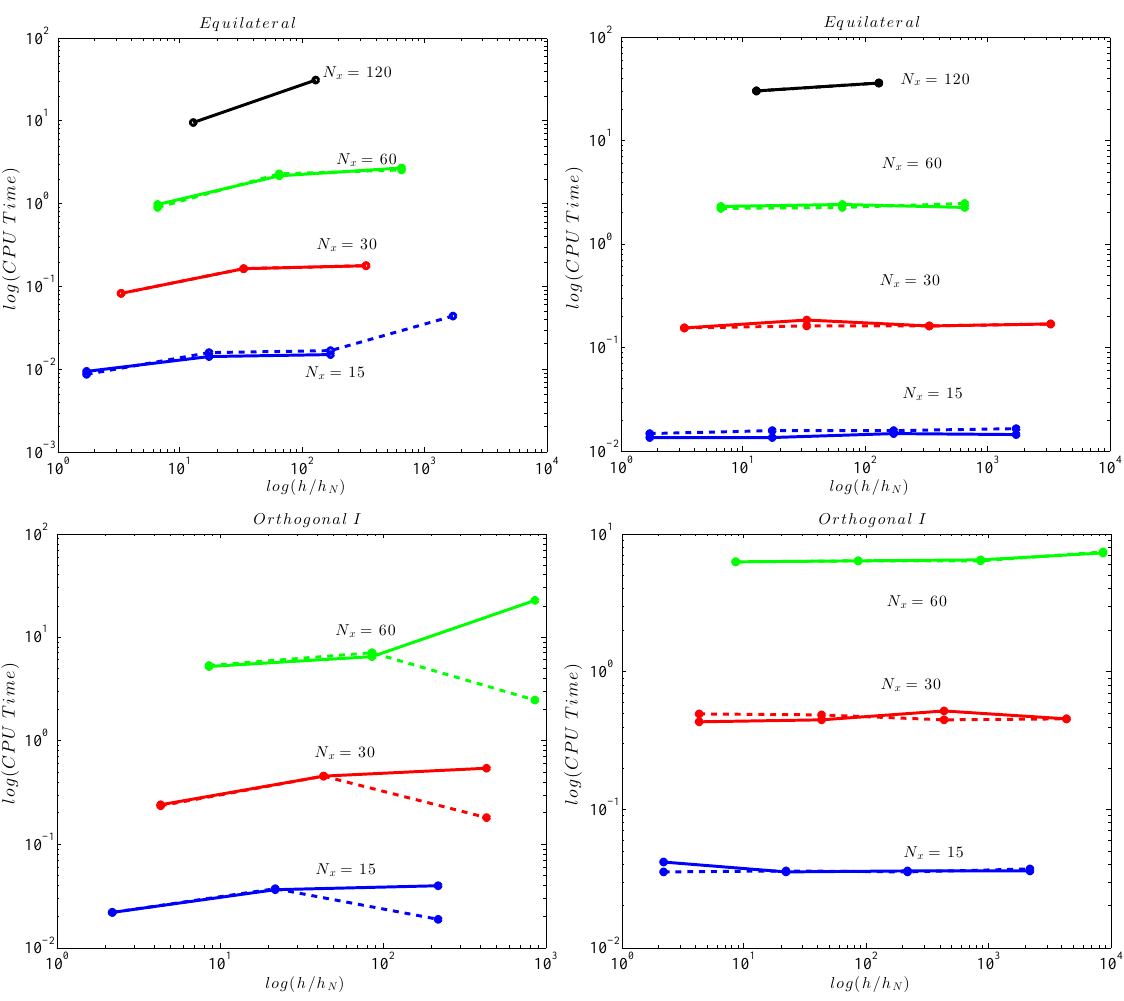
Figure 12. CPU time versus variable water depth for GMRES (solid line) and BiCGStab (dashed line) using ILUT preconditioner with threshold 10 − 5 ( left ) and 10 − 10 ( right ) and RCM reordering for Equilateral type of grids ( up ) and Orthogonal I types ( down